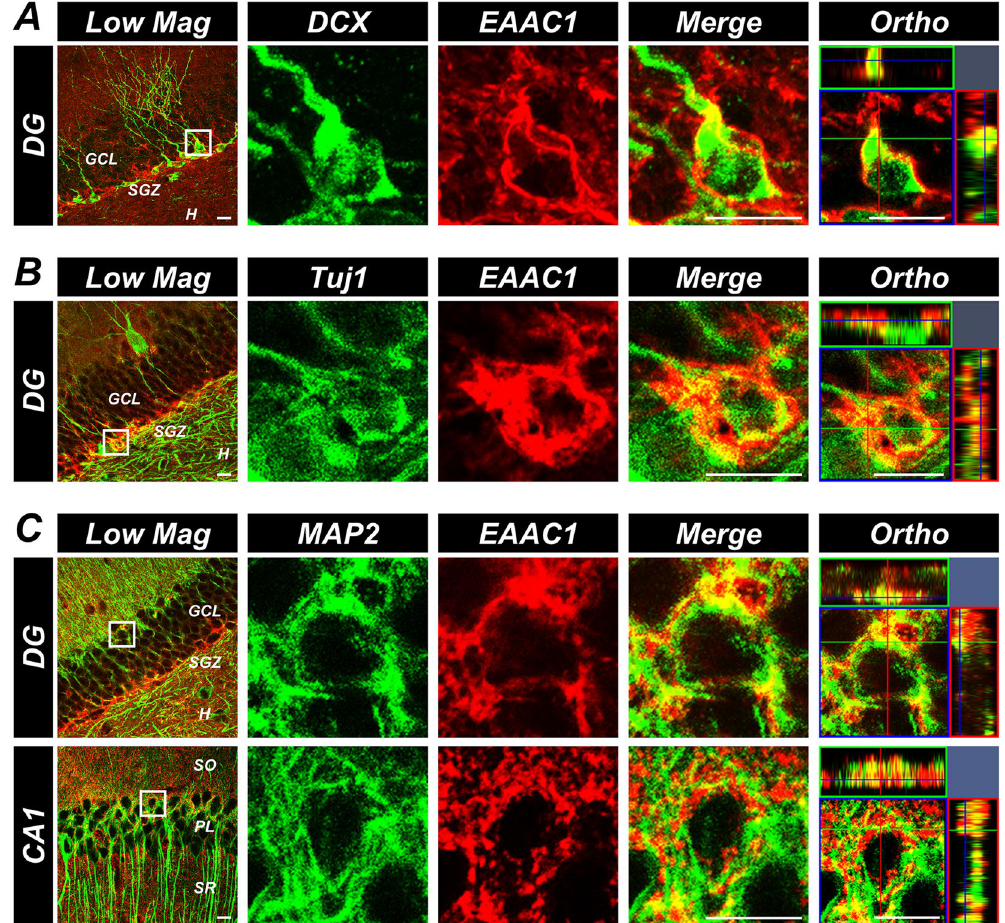
Figure 1. EAAC1 is expressed in mature and immature neurons. ( A ) Representative immunofluorescence images show DCX (green) and EAAC1 (red) immunoreactive (DCX + / EAAC1 + ) cells in the DG. ( B ) Representative immunofluorescence images reveal Tuj1 (green) and EAAC1 (red) immunoreactive (Tuj1 + / EAAC1 + ) cells in the DG. ( C ) Representative immunofluorescence images show MAP2 (green) and EAAC1 (red) immunoreactive (MAP2 + / EAAC1 + ) cells in the DG and CA1. Scale bar = 10 μ